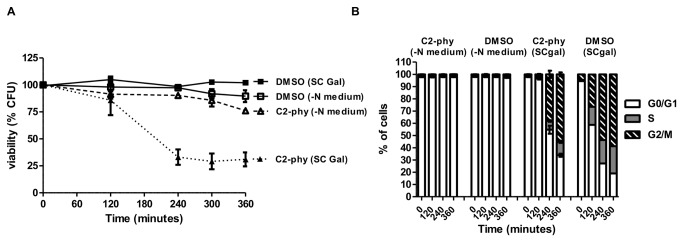

S. cerevisiae cells in G2/M are more sensitive to C2-phytoceramide.(A) Survival of W303-1A cells synchronized in nitrogen starvation medium. Cells were transferred to SC gal medium and then exposed to 30 µM C2-phytoceramide (▼-dashed lines) or equivalent volume of solvent (■), or maintained in nitrogen starvation medium and exposed to 30 µM C2-phytoceramide (∇-dashed lines) or equivalent volume of solvent (□). CFU values of cells transferred to SC gal and treated with 30 µM C2-phytoceramide are significantly different from C2-phytoceramide treated cells kept in nitrogen starvation medium and from DMSO-treated cells transferred or not to SC Gal, for all time points, P<0.001, Two-Way ANOVA. All CFU values represent mean ± SE of at least 3 independent experiments, with 5 replicas in each experiment. (B) Cell cycle progression of the cells described in (A). Data represent mean ± SE of at least 3 independent experiments.